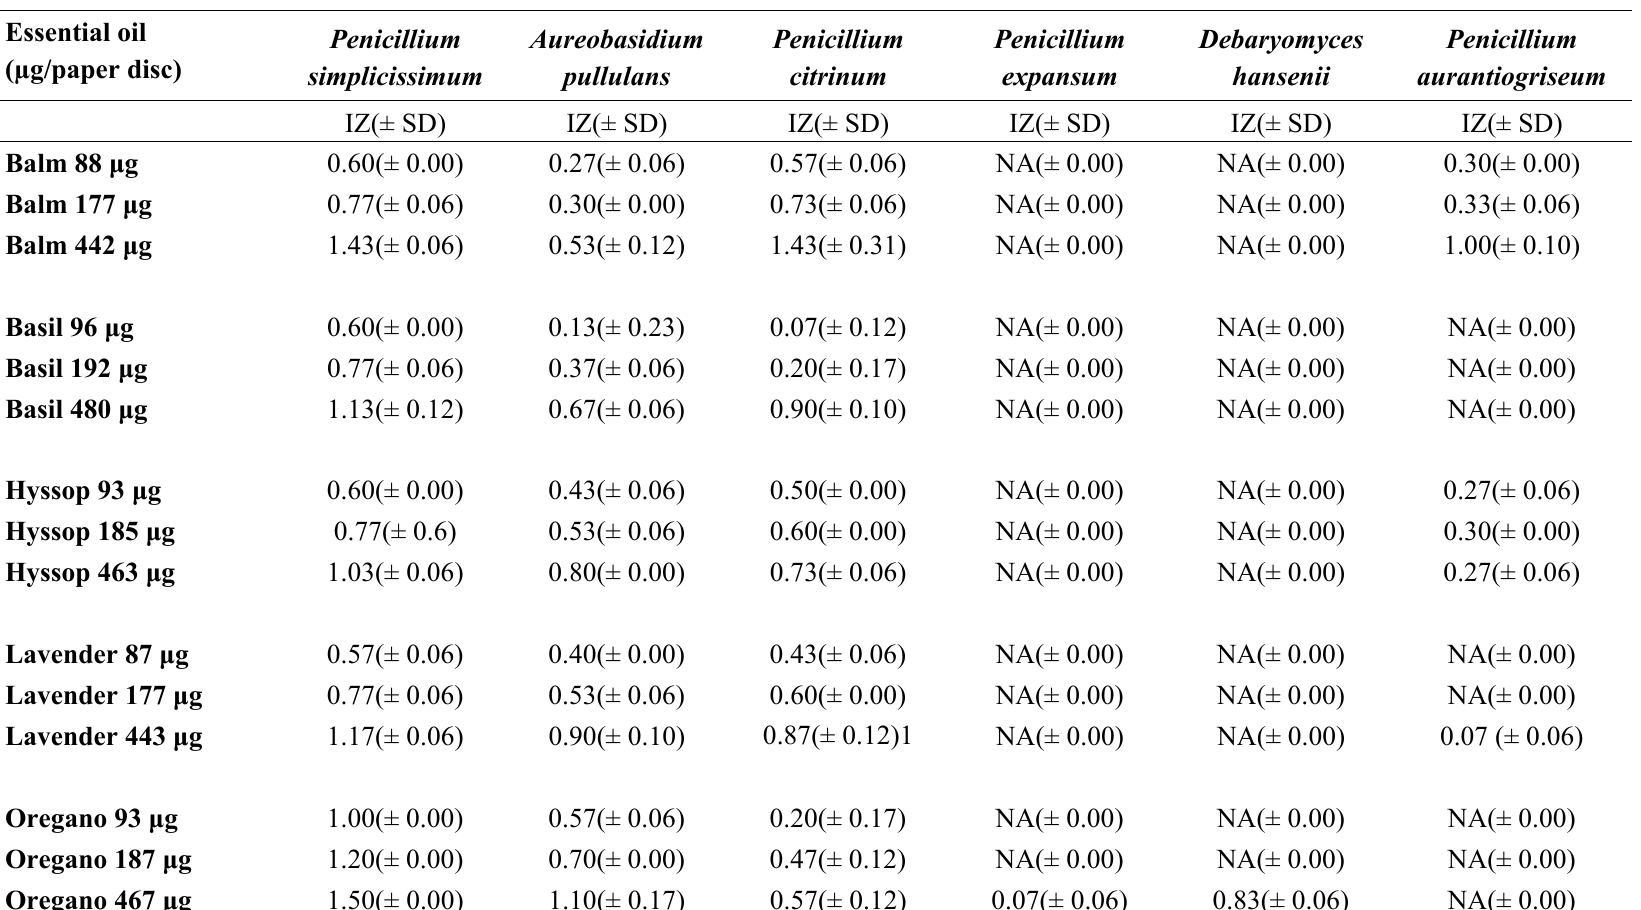
Table 3. Inhibition of fungal growth of essential oils: Melissa officinalis L. (balm) , Ocimum basilicum L . (basil), Hyssopus officinalis L. (hyssop) , Lavandula angustifolia Mill. (lavender) , Origanum vulgare L. (oregano) , Salvia officinalis L . (sage), Thymus vulgaris L. (thyme). Data are expressed in cm and do not include the diameter of paper disc. Results are shown as mean ± standard deviation (SD) of the inhibition zone (n =